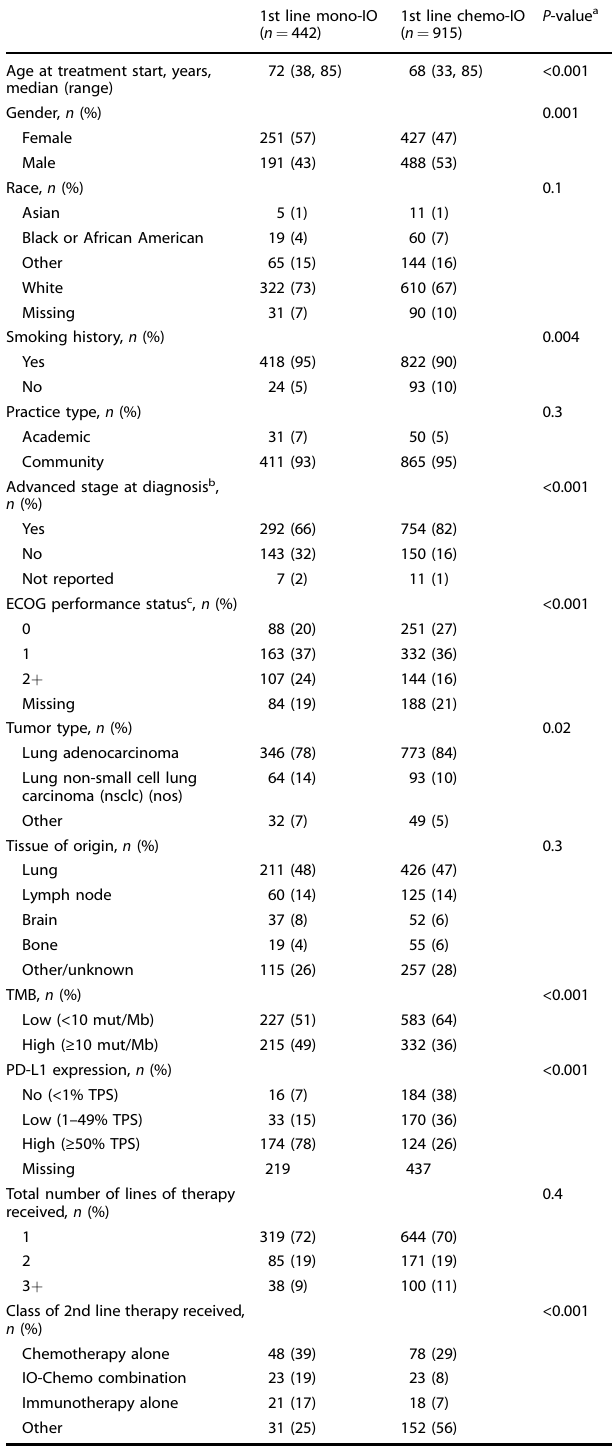
Table 1. Demographic and clinical characteristics by treatment